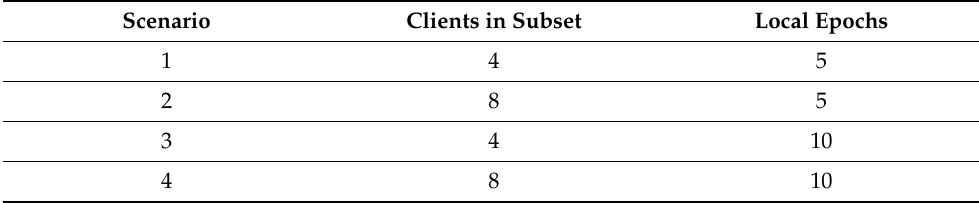
Table 4. Evaluated scenarios.